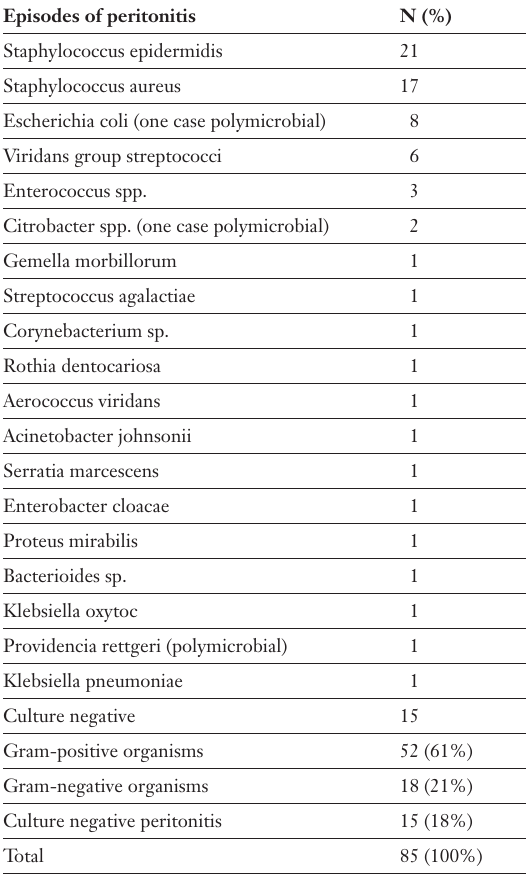
nitis organisms.